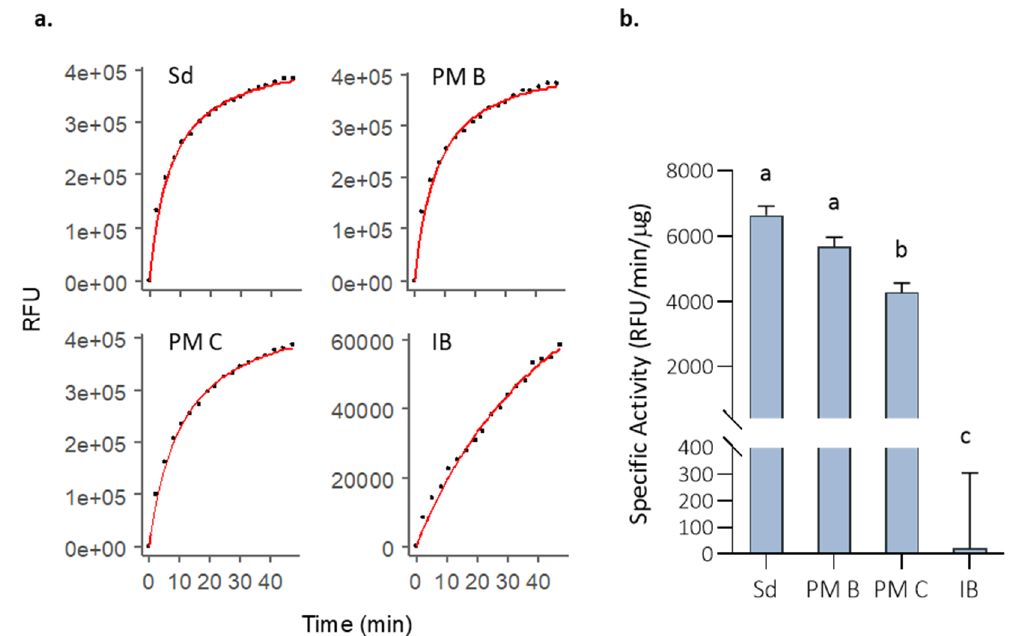
Figure 2. Initial MMP-9 activity ( t = 0 h) in PBS incubations for the analyzed formats. ( a ) DQ-gelatin degradation kinetics for one of the replicates of 10 µg of solubilized MMP-9 (Sd), 10 µg of non- covalent MMP-9-PM (PM B), 10 µg of covalent MMP-9-PM (PM C), and 100 µg MMP-9 IBs (IB). Fluorescence reads along time (dots), and R model curves (red line) are represented. RFU = Relative fluorescence units. ( b ) Comparison of the specific activity (RFU corrected by time and MMP-9 µg) for the analyzed formats. Means and SEM are represented. Data were analyzed, using a fixed effect model with format as fixed effect. Different letters depict significant differences ( p = 0.0003).